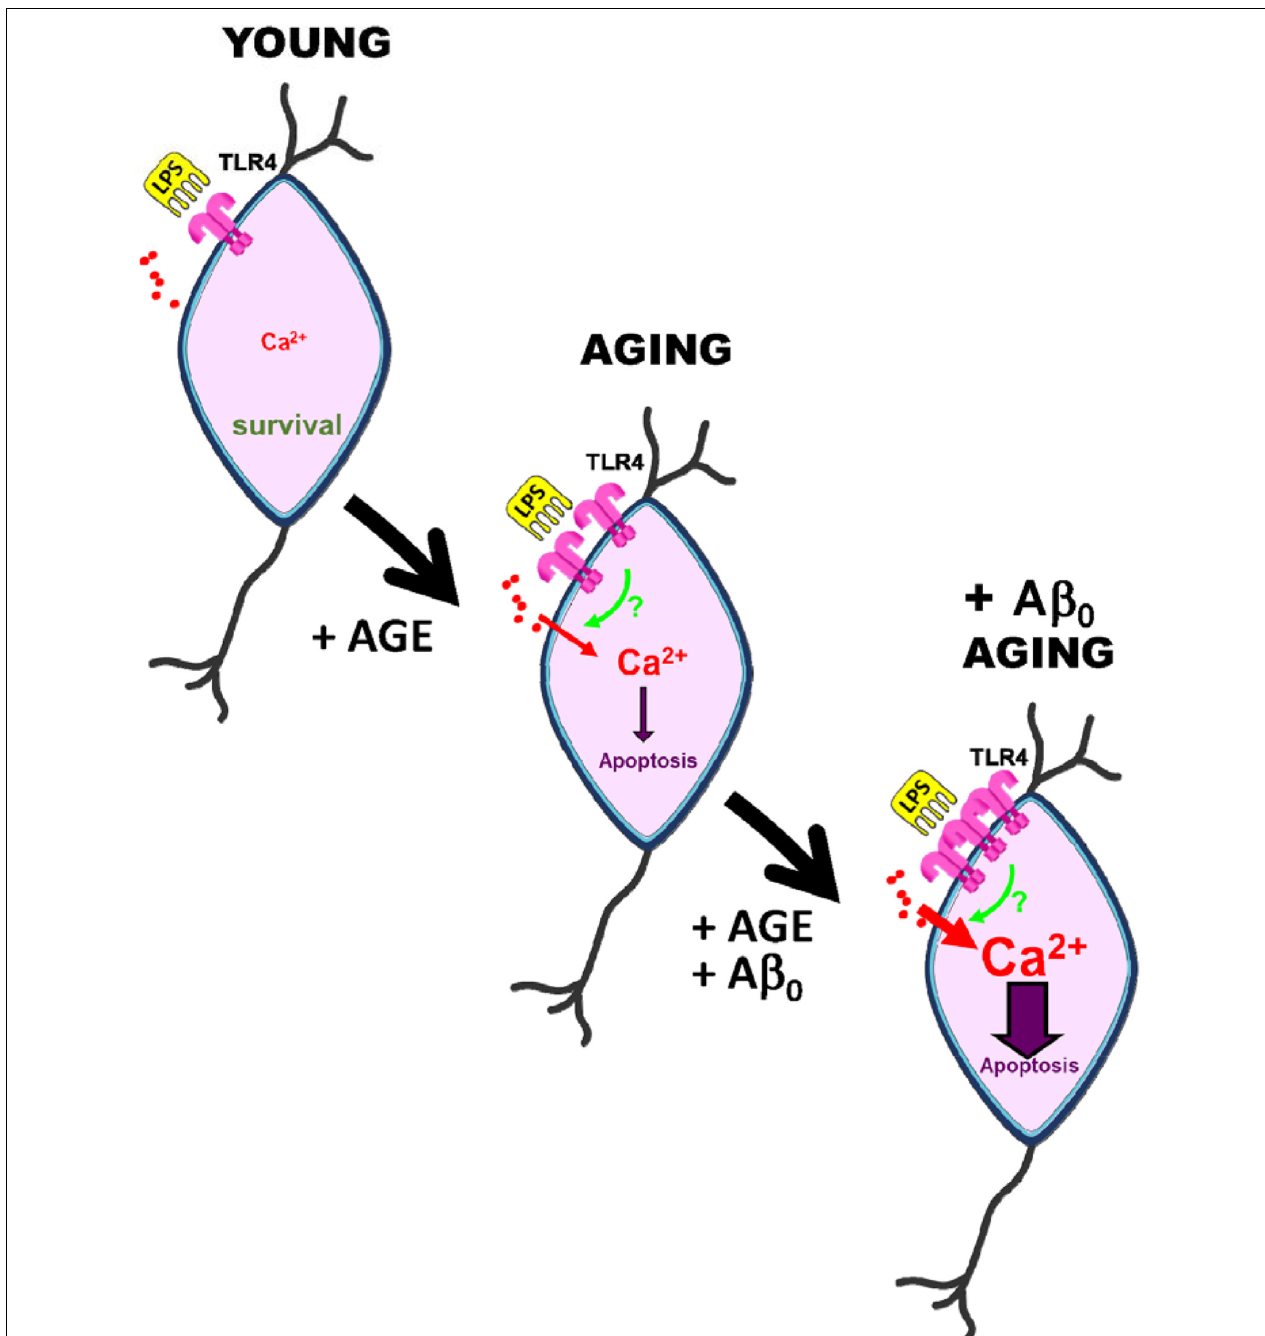
FIGURE 1 | Effects of aging and amyloid oligomers on TLR4 induced Ca 2 + signaling and death in rat hippocampal neurons aged in vitro . Short-term cultures of rat hippocampal neurons, resembling young neurons, display low expression of TLR4, and the TLR4 agonist LPS has no effect on cytosolic Ca 2 + concentration or cell death. However, long-term cultured neurons resembling aged neurons display enhanced TLR4 expression, increased Ca 2 + responses to LPS, and neuronal cell death. All three of these effects are exacerbated in aged neurons treated with amyloid β oligomers involved in Alzheimer’s disease, suggesting a crosstalk between TLR4 and amyloid β -induced Ca 2 + signaling